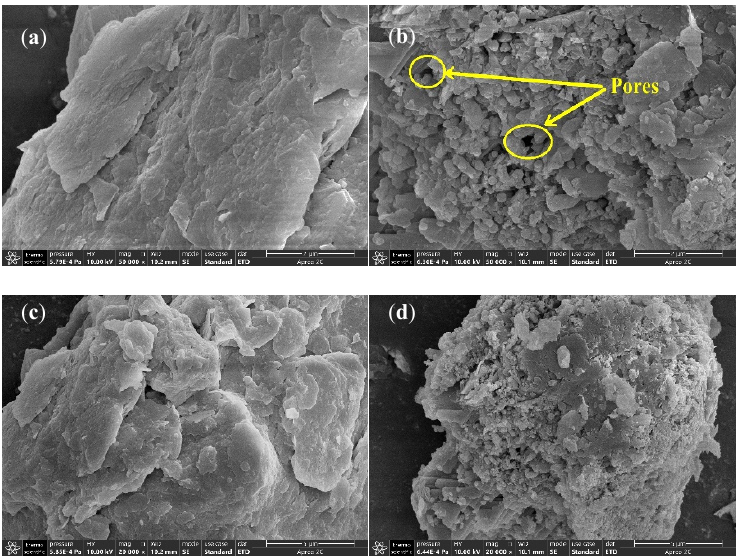
Figure 7. SEM images of uncontaminated and acid-contaminated soils for ( a ) pH = 7, 2 μ m; ( b ) pH = 2, 2 μ m; ( c ) pH = 7, 5 μ m; ( d ) pH = 2, 5 μ m.